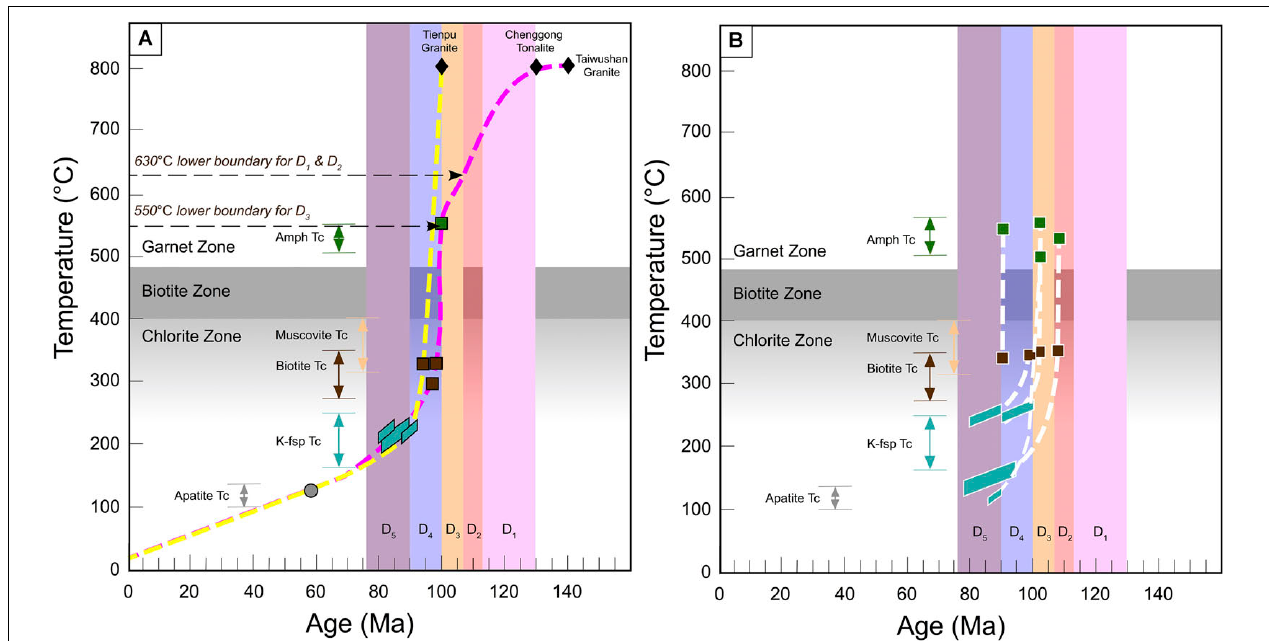
FIGURE 12 | Reconstructed cooling path of the Cretaceous magmatism of (A) Kinmen Island and (B) nearby regions based on previously published geochronological results (Lo et al., 1993; Lin, 1994; Yui et al., 1996; Chen et al., 2002; Lin et al., 2011). (A) The dashed pink line describes the cooling path for the 139 Ma Taiwushan Granite and the 129 Ma Chenggong Tonalite, while the dashed yellow line delineates the cooling path of the 100 Ma Tienpu Granite. (B) The cooling path of the gneiss within the PDMB from samples FJ07, FJ08, FJ12, and FJ17 in Chen et al. (2002). The closure temperature ranges for different mineral systems are as followed: U-Pb zircon ( > 800–900 ◦ C; solid black diamond Lee et al., 1997), Ar-Ar amphibole (Amph; solid green square 500–550 ◦ C; Harrison, 1982), Ar-Ar muscovite (350 ± 50 ◦ C; McDougall and Harrison, 1999), Ar-Ar biotite (275–350 ◦ C; solid brown square Döpke, 2017), Ar-Ar K-feldspar (K-fsp; solid green parallelogram 250–150 ◦ C; Harrison and McDougall, 1982), apatite fission track (110 ± 10 ◦ C; solid gray circle Gleadow and Duddy, 1981). The timing for the five deformation events (D 1 –D 5 ) are distinguished by correlating the metamorphic conditions proposed in this study to the reconstructed cooling